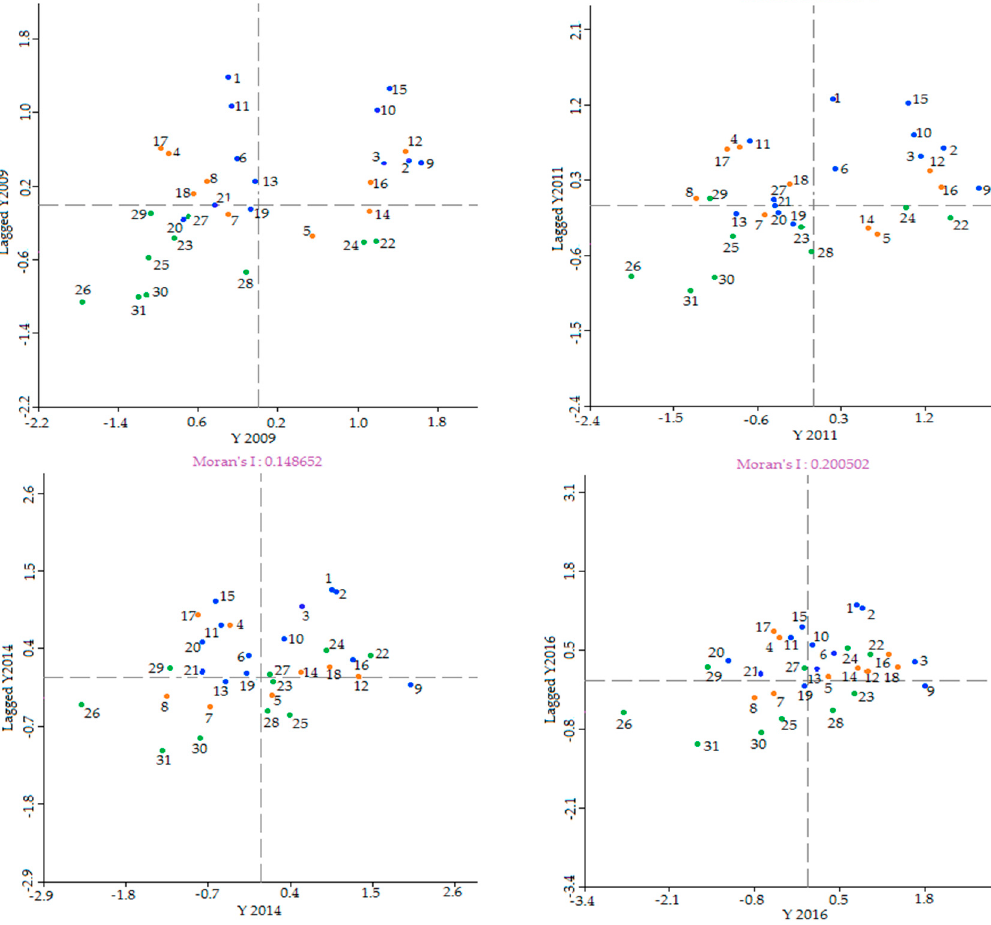
Figure 7. Moran’s I scatter graphs of ITEs in China. Note: The provinces are numbered as follows: 1. Beijing; 2. Tianjin; 3. Hebei; 4. Shanxi; 5. Inner Mongolia; 6. Liaoning; 7. Jilin; 8. Heilongjiang; 9. Shanghai; 10. Jiangsu; 11. Zhejiang; 12. Anhui; 13. Fujian; 14. Jiangxi; 15. Shandong; 16. Henan; 17. Hubei; 18. Hunan; 19. Guangdong; 20. Guangxi; 21. Hainan; 22. Chongqing; 23. Sichuan; 24. Guizhou; 25. Yunnan; 26. Tibet; 27. Shaanxi; 28. Gansu; 29. Ningxia; 30. Qinghai; 31. Xinjiang. The provinces represented by blue, orange and green dots are located in the eastern, central and western regions of China, respectively. Table 5. Changes in corresponding ITE